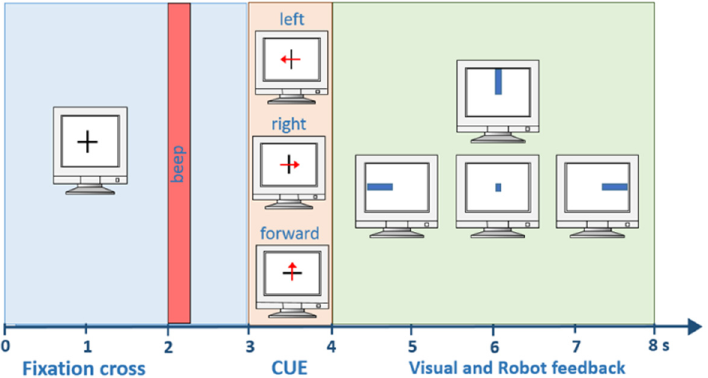
Figure 2. Timing within one trial.